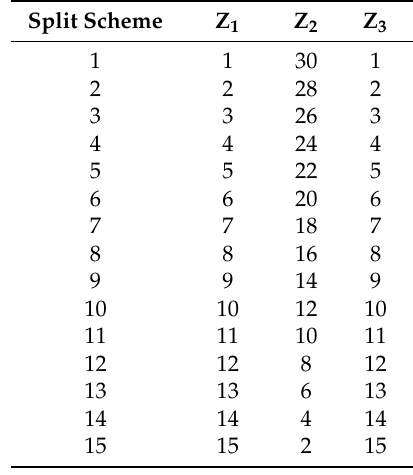
Table 1. The symmetrical split schemes with K = 3 for a 32 × 32